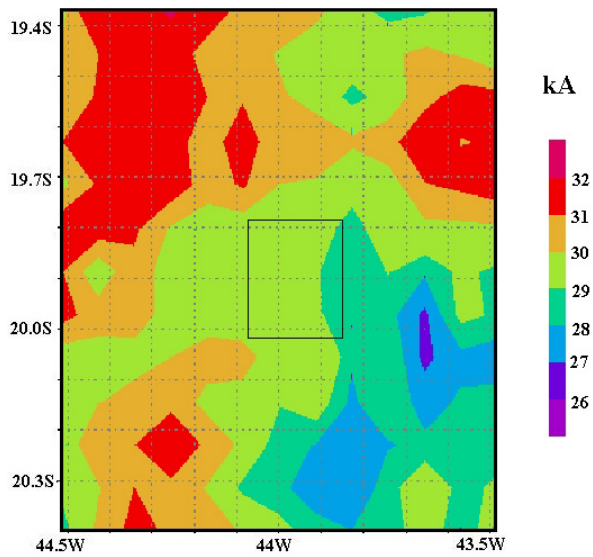
Fig. 6. As in Fig. 5, except for positive peak current.